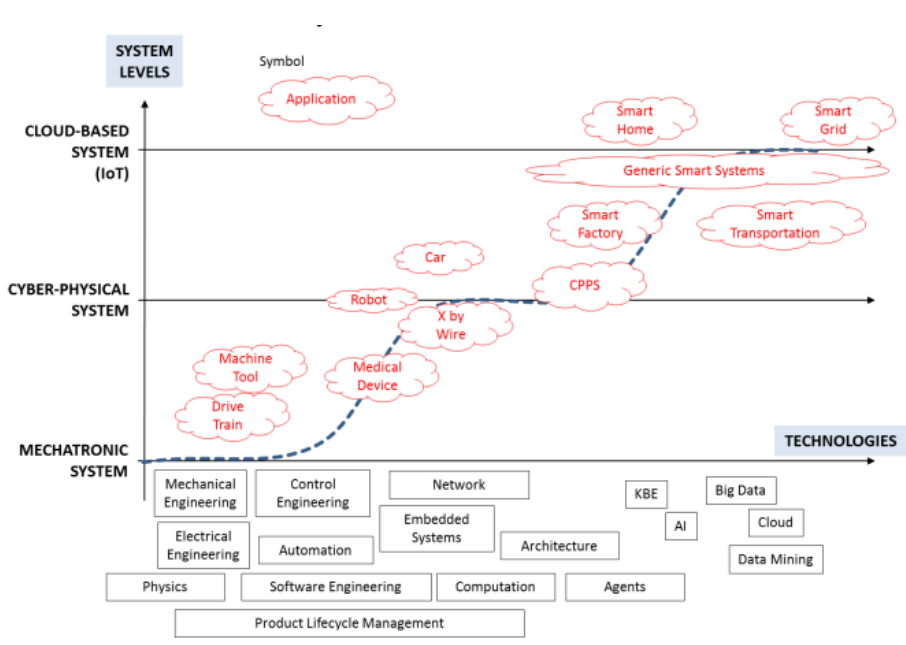
Figure 20. Evolution of mechatronic systems towards CPS and IoT [149].